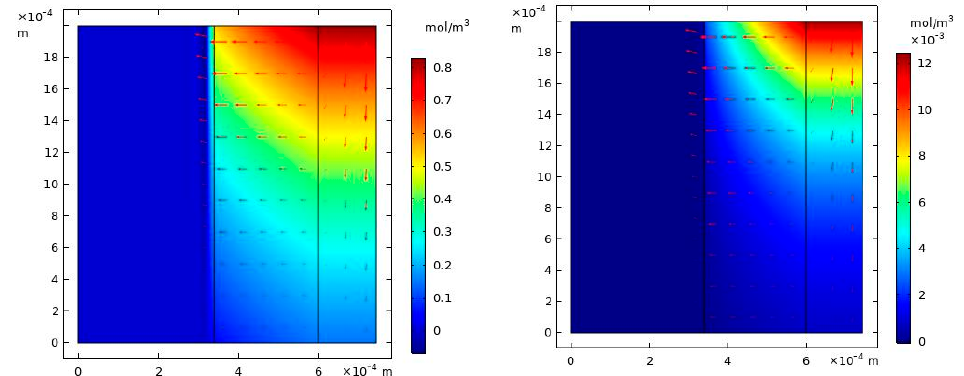
Figure 2. The 2D surface plot for the concentration profile of CO 2 (left) and NO 2 (right) at other fixed parameters (velocity of gas: 1.05 m/s; liquid rate: 0.02 m/s; 2% CO 2 ; 300 ppm NO 2 ; the balance is N 2 , initial concentration of CO 2 and NO 2 , 0.832 mol/m 3 , 0.0125 mol/m 3 , respectively).